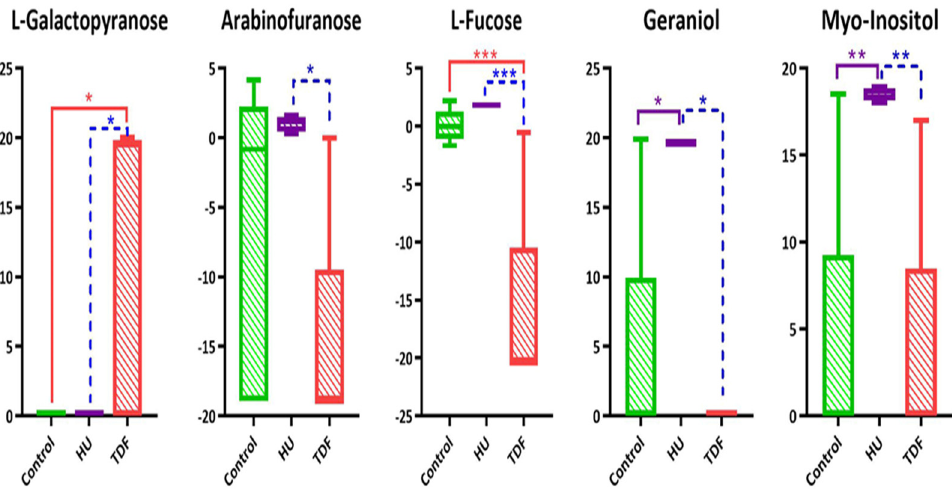
Figure 6. Box plots of the altered metabolites between the studied groups showing average concen- trations of the specific metabolites and p -value calculated by one-way ANOVA (non-parametric), post hoc Bonferroni statistical hypothesis testing (* show p -value < 0.05, ** show p -value < 0.01, and *** show p -value < 0.001).